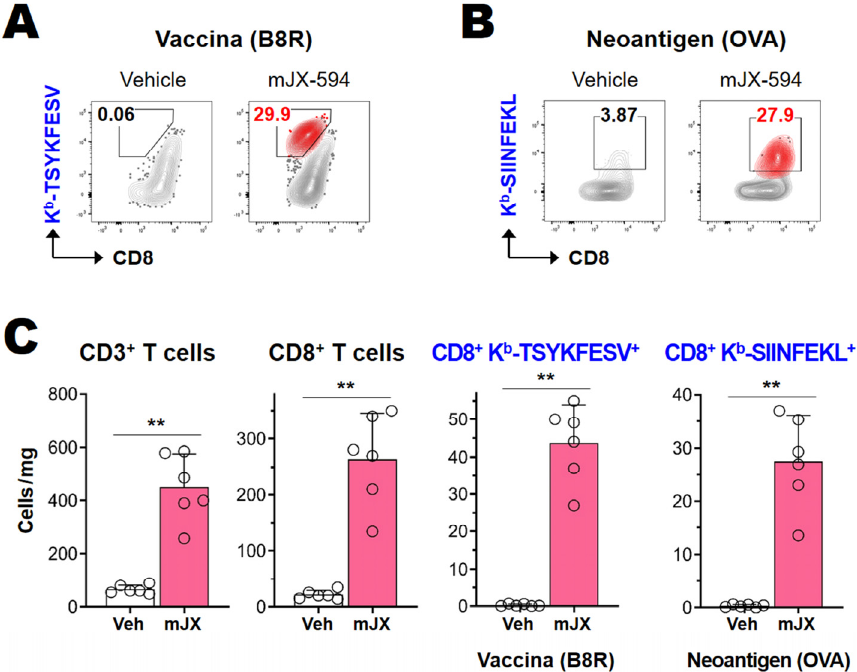
Figure 3. Cancer-specific CD8 + T cells and vaccinia virus-specific CD8 + T cells were efficiently activated and recruited to the tumor tissue. LLC-OVA cancer cells were subcutaneously implanted into C57BL/6 mice. When tumors reached 50–60 mm 3 in volume, the mice were intratumorally injected with vehicle or 5 × 10 7 pfu of mJX-594 on days 0, 3, and 6. The tumor-infiltrating leukocytes were analyzed by flow cytometry on day 3 after the last treatment with mJX-594. ( A ) The proportion of vaccinia virus B8R-specific CD8 + T cells (K b -TSYKFESV tetramer-positive) among CD3 + T cells. ( B ) The proportion of neoantigen (OVA)-specific T cells (K b -SIINFEKL dextramer-positive) among CD3 + T cells. ( C ) Cell number per milligram of tumor mass of intratumoral CD3 + T cells, CD8 + T cells, B8R vaccinia-specific CD8 + T cells, and OVA-specific CD8 + T cells after mJX-594 treatment. Pooled data from two experiments are shown ( n = 6 per group). ** p < 0.005. LLC-OVA, LLC